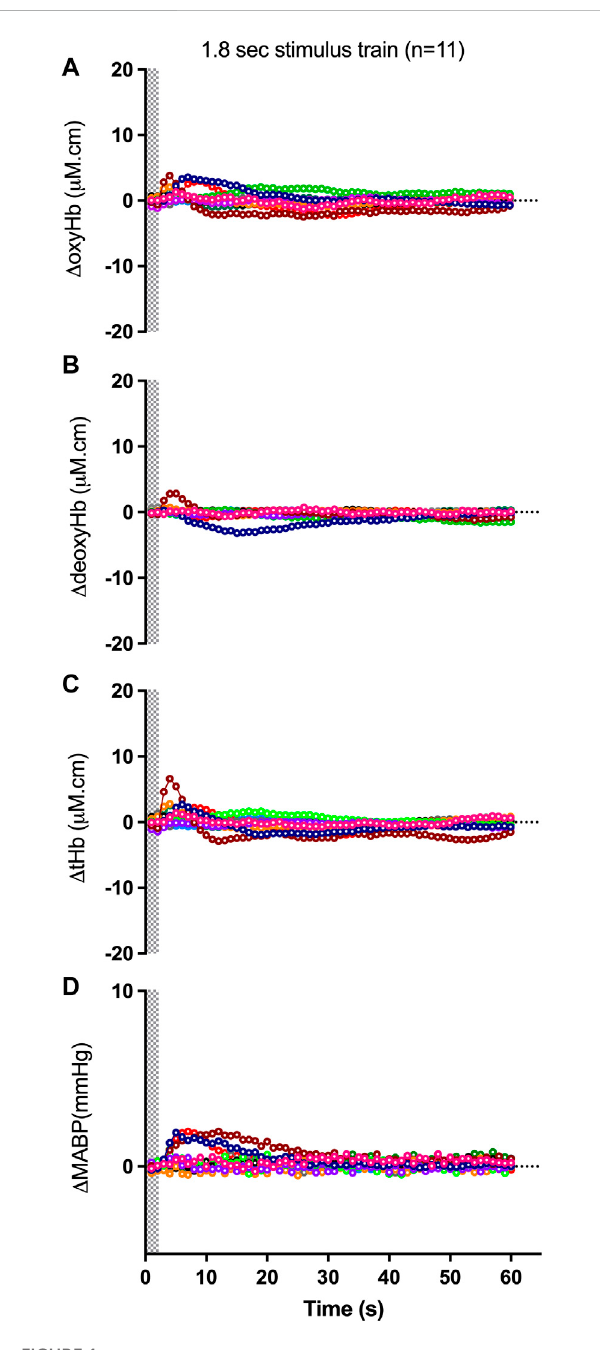
FIGURE 1 Changes in oxy-, deoxy- and total haemoglobin [ Δ oxyHb; (A) , Δ deoxyHb; (B) and Δ total Hb; (C) ], recorded from the contralateral hemispheres,andmeanarterialbloodpressure[ Δ MABP; (D) ],followinga 3.3 Hz stimulus train of 1.8 s duration in control preterm lambs. Individual lambs are shown by different colours. Shaded area in each graph indicates the period of